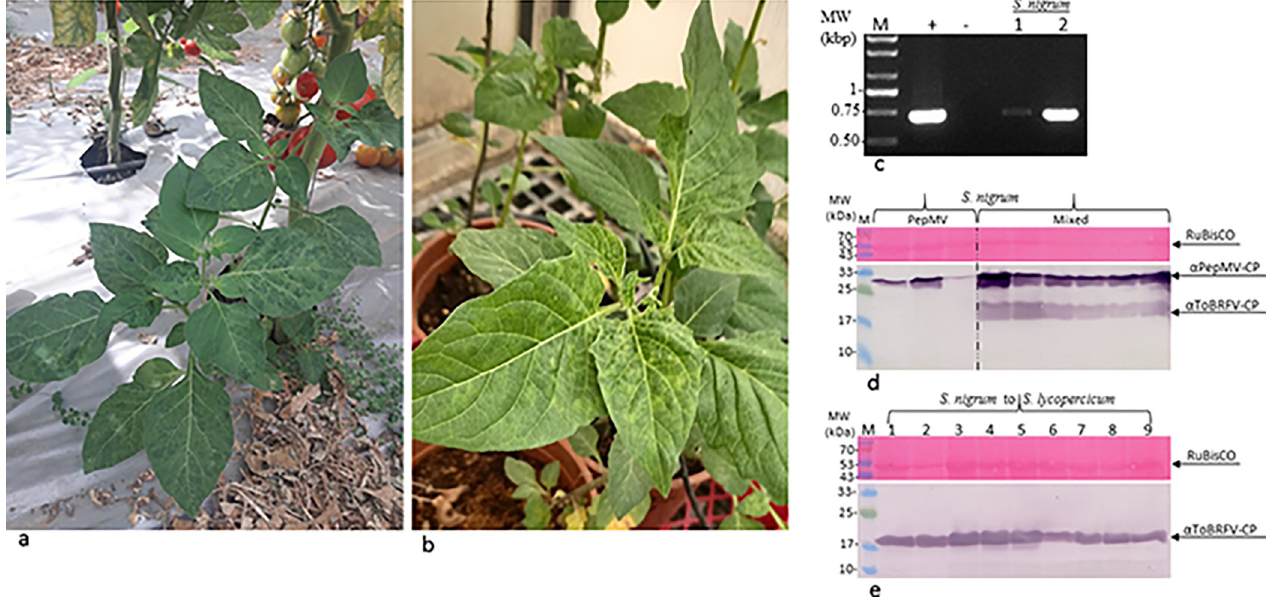
Fig 3. S . nigrum shows synergism upon mixed infections with ToBRFV and the mild strain PepMV-IL. (a) ToBRFV-infected naturally occurring S . nigrum showing mottled mosaic leaves grew adjacent to tomato plants in a commercial tomato greenhouse. (b) A ToBRFV-inoculated S . nigrum plant showing mild mottled leaves. (c) RT-PCR of ToBRFV-infected S . nigrum , confirmed by Sanger sequencing. (d) A western blot analysis showing a viral synergism in S . nigrum plants upon mixed infection with ToBRFV and PepMV-IL. (e) A bioassay of ToBRFV-inoculated S . nigrum plants using tomato plants bearing the Tm-2 2 resistance gene. M, molecular size marker; (+), a positive control for ToBRFV from tomatoes; (-) a healthy control; numbers represent different plants inoculated with ToBRFV.